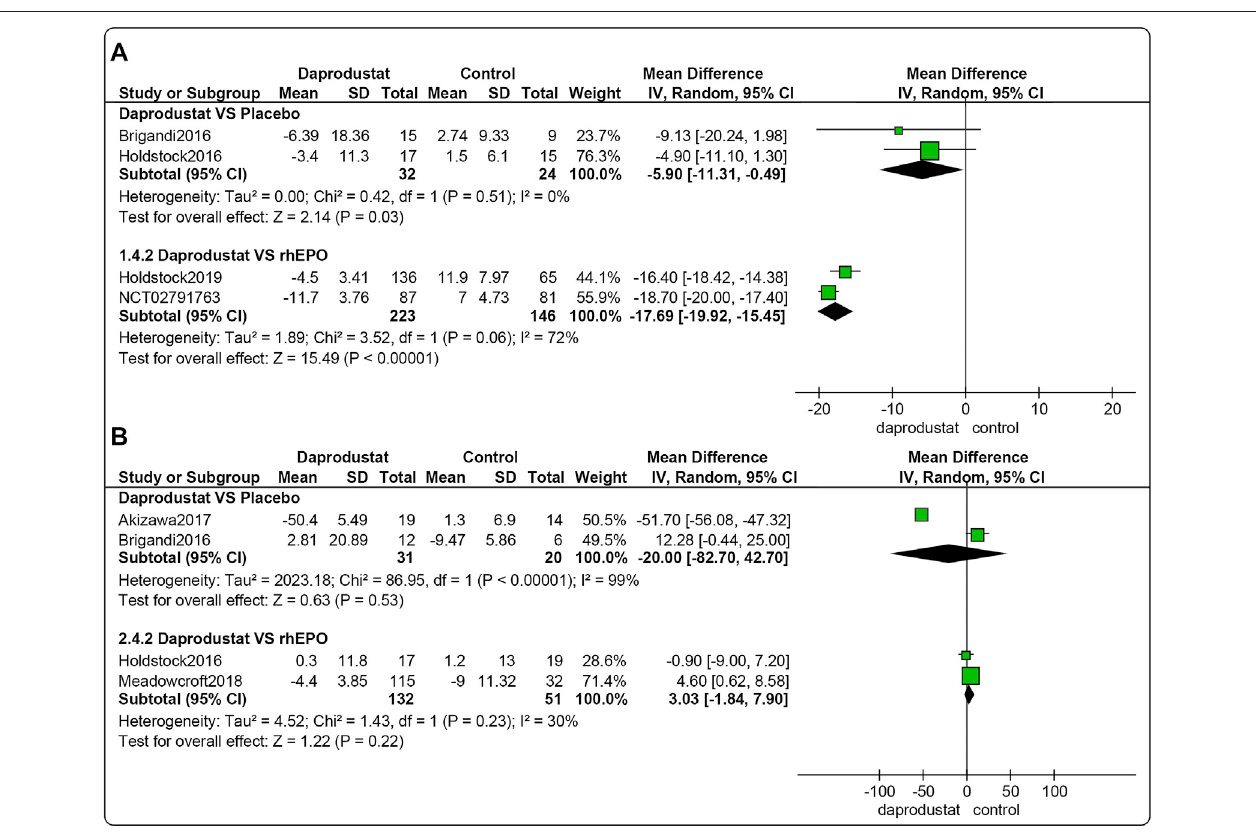
FIGURE 5 | The meta-analysis results of daprodustat for △ TSAT. (A) The pooled results for NDD patients; (B) The pooled results for DD patients.